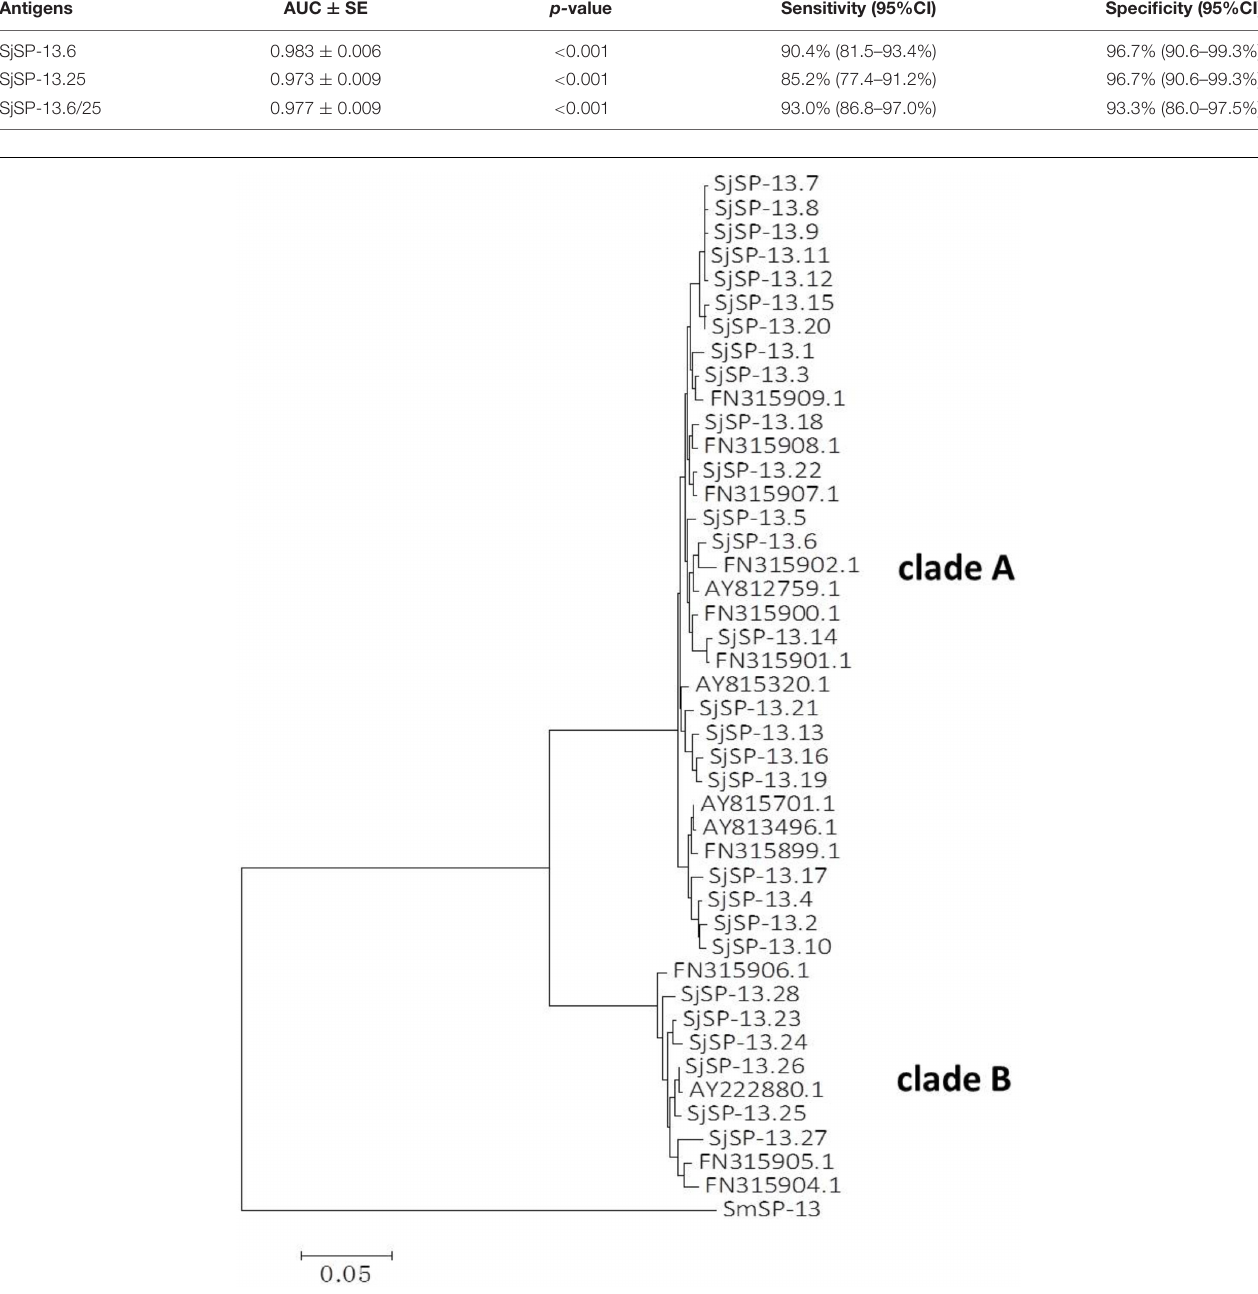
Diagnostic Efficacy of Different SjSP-13 We collected 115 serum samples from schistosomiasis patients in Hunan and Jiangxi Provinces. 90 serum samples from healthy volunteers were collected as controls. The SjSP-13 antibody levels in the human sera were determined using the ratio